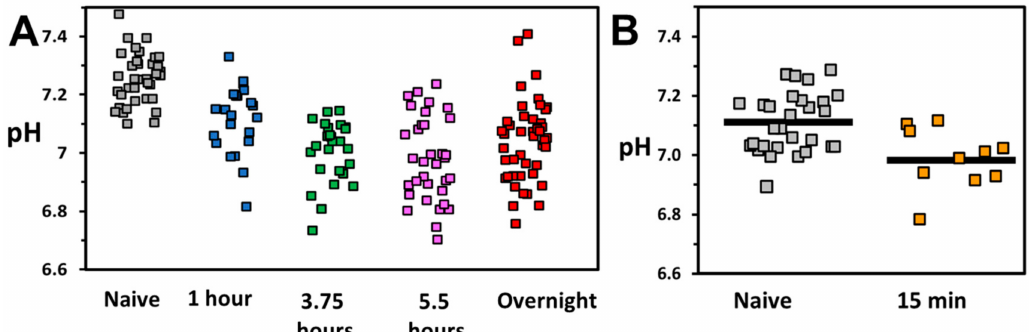
Figure 2. ( A ) pH of droplets containing Jurkat T-cells plotted vs. activation time with activator beads. Each marker represents the pH of one droplet with one encapsulated cell. Grey markers represent naive cells which were not exposed to activator beads. Ordinary one-way ANOVA with Dunnett’s multiple comparisons test: 1 h ( p = 0.0002), 3.75 h ( p < 0.0001) 5.5 h ( p < 0.0001), overnight ( p < 0.001). ( B ) pH of cells exposed to 15 min of activation compared to naive cells. Horizontal bar represents average pH value. Two-tailed Student’s t -test ( p =